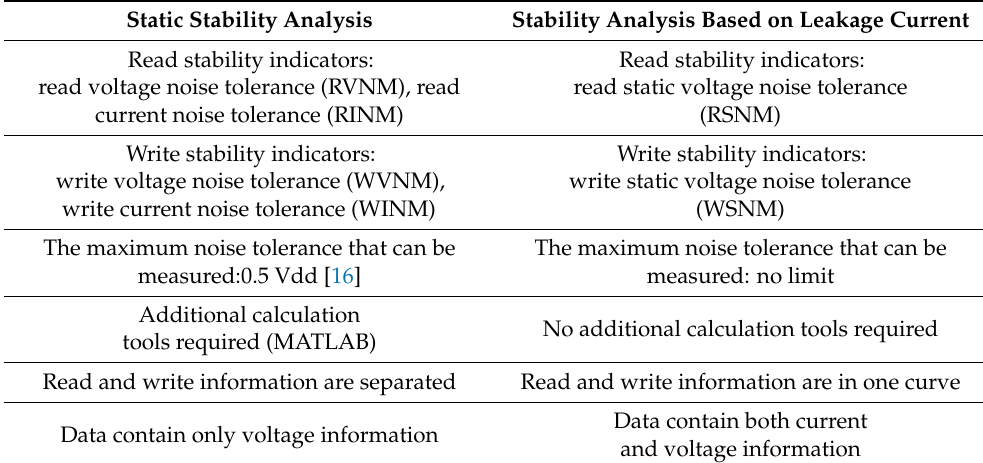
Table 1. Comparison of stability and static stability based on leakage